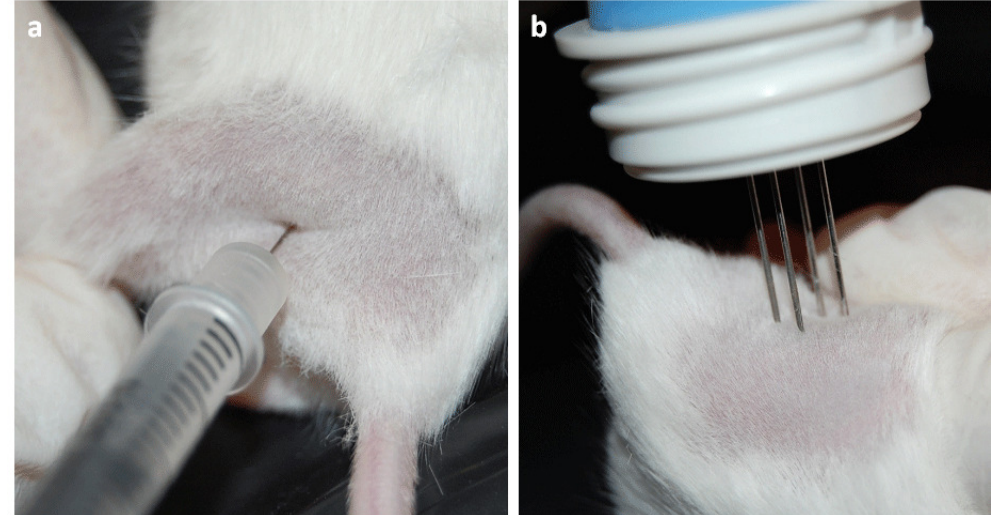
Figure 2. Electro gene transfer performed with the Cliniporator™ (IGEA Srl, Carpi, Italy). (a) 25 µ g of plasmids diluted in 20 µ L of saline were injected into the quadriceps muscle of anesthetized mice; (b) Immediately after the injection two electric pulses consisting of a low-voltage pulse of 100 V and of 200-ms duration were applied by an array needle electrode inserted in the injected